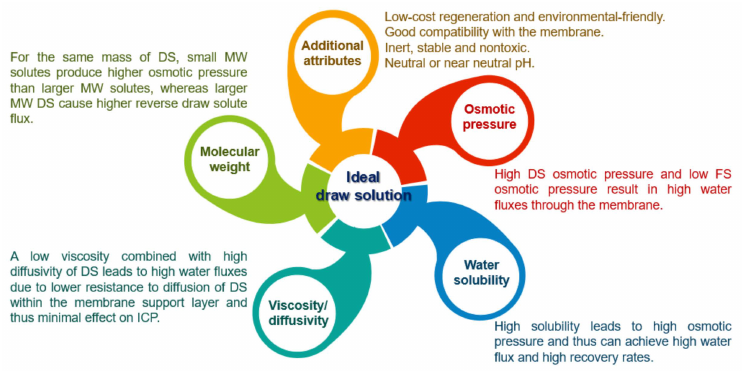
Figure 10. Some important characteristics of an ideal draw solution